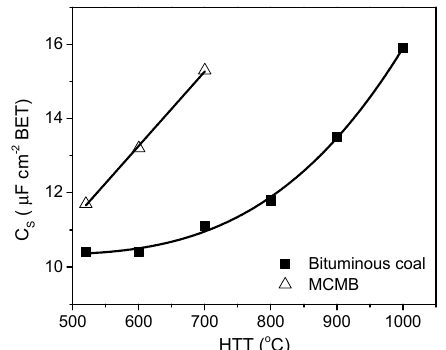
Figure 21. Relation between the specific surface capacity (normalized to BET surface area) of ACs produced by KOH activation at 700 °C and the HTT of different precursors: bituminous coal and mesocarbon microbeads. Reproduced from [163] with permission from Elsevier © 2012. Electrochemical measurement in 6 mol L − 1 KOH.